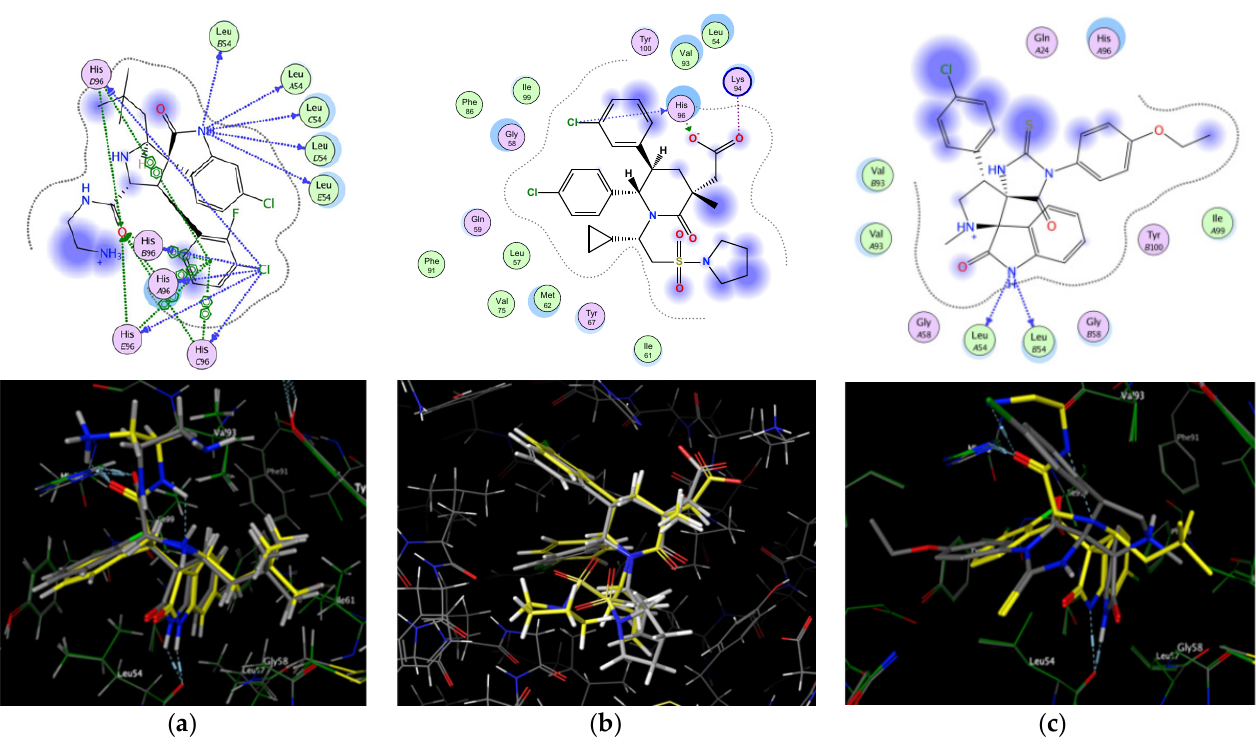
Figure 6. Compound XX ( a ), compound XXI ( b ), and compound 29 ( c ) docked in the MDM2 pocket. Yellow : X-ray data for compounds XX ( a ) (PDB code: 4JVR, resolution: 1.70 Å) and XXI ( b ) (PDB code: 4QOC, resolution: 1.70 Å); grey — docking results. For ( a ): E score = − 8.49 kcal/mol; for ( b ): E score = − 7.62 kcal/mol; for ( c ): E score = − 5.31 (compound 26 ); low E score values correspond to more favorable binding.